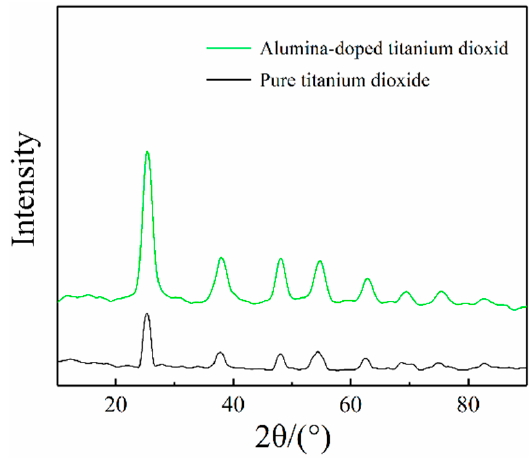
Figure 2. XRD pattern of alumina-doped titanium dioxide and pure titanium dioxide particles.